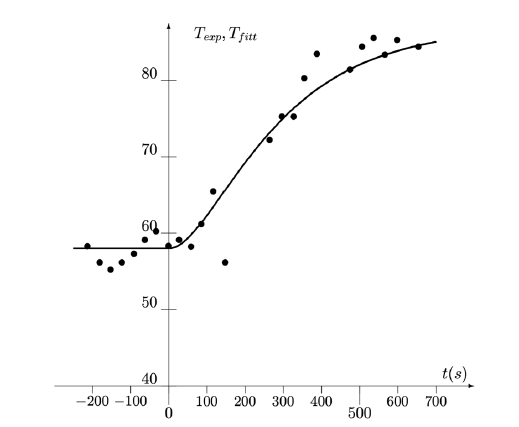
Figure 2. Experimental recorded CPU temperature T exp ( • ) compared with an analytical function T fitt .